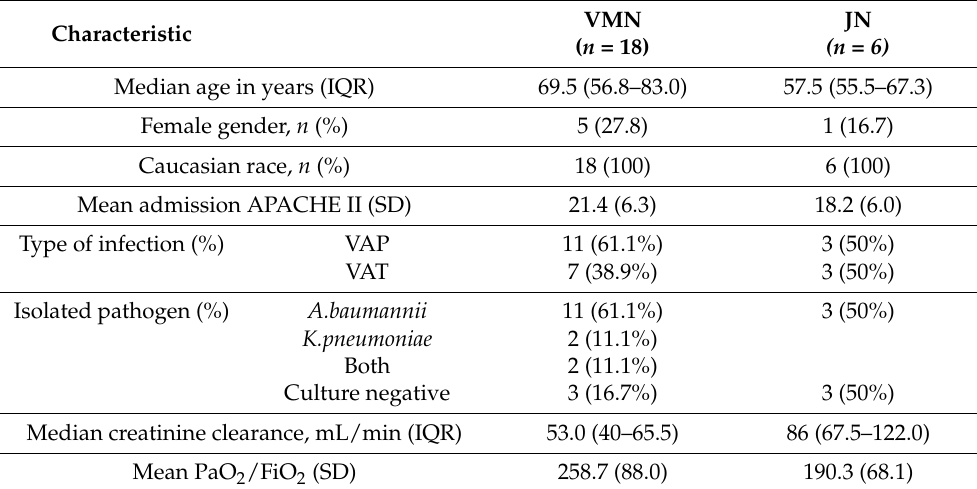
Figure 1. Patient flow chart. iv: intravenous, neb: nebulized. Table 1. Patient baseline characteristics. VMN: vibrating mesh nebulizer; JN: jet nebulizer; IQR: interquartile range; APACHE II: Acute Physiology and Chronic Health Evaluation II score; VAP: ventilator-associated pneumonia; VAT: ventilator-associated tracheobronchitis.